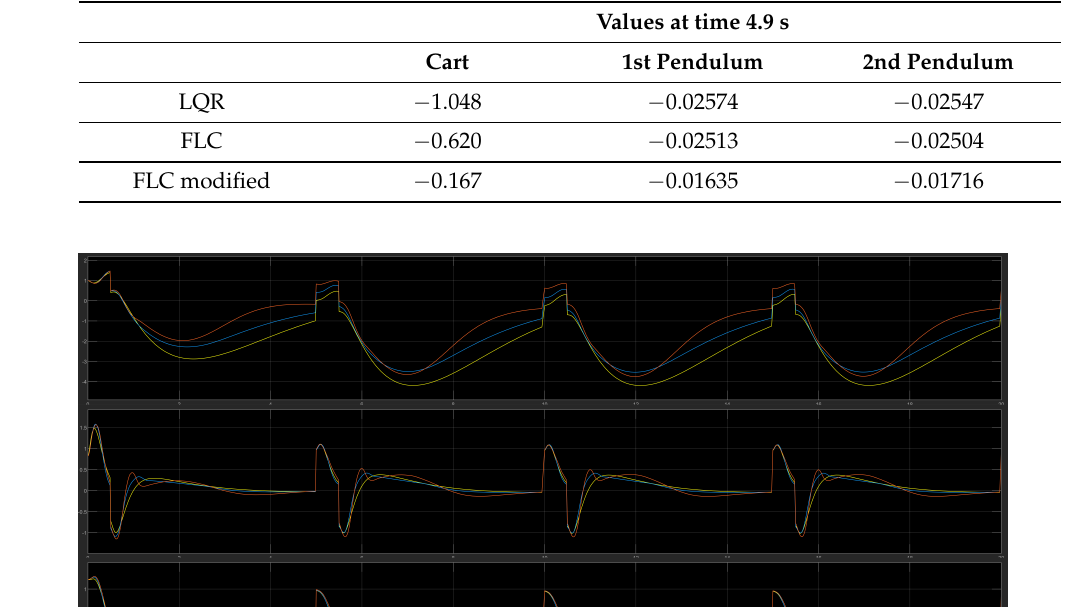
Table 2. Comparative values under disturbance for all elements at simulation time 4.9 s.